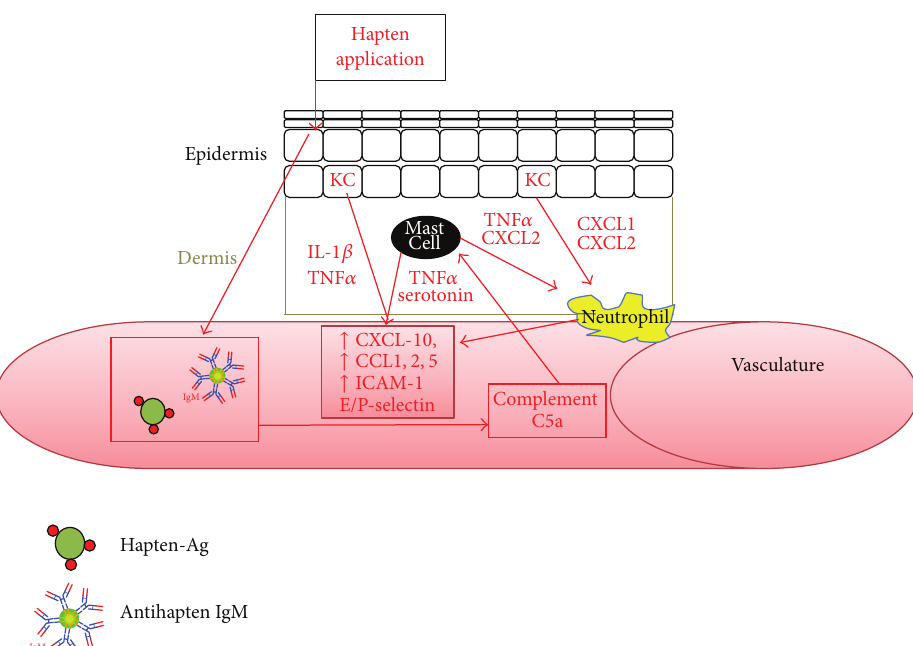
Figure 2: The likely pathway of the “early elicitation” phase of contact hypersensitivity. The red arrows and type indicate the early elicitation phase. Hapten challenge will restimulate iNKT cells to release IL-4, which along with hapten-antigen will stimulate CS-initiating B-1 cells as seen in Figure 1. These cells will release IgM, which will bind to hapten-antigen. This will cause formation of C5a, triggering activation of mast cells to produce TNF 𝛼 and serotonin, increasing immune cell trafficking into the area and TNF 𝛼 and CXCL2 to stimulate neutrophils in the dermis. Neutrophils will also be activated by CXCL1 and CXCL2 released from haptenation of the keratinocytes. Their activation will cause damage at the challenge site as well as more CXCL1 and CXCL2 release, inducing immune cell trafficking to the area as illustrated in Figure 3. Lastly, haptenated keratinocytes will release cytokines to induce immune cell trafficking to the area as depicted in Figure